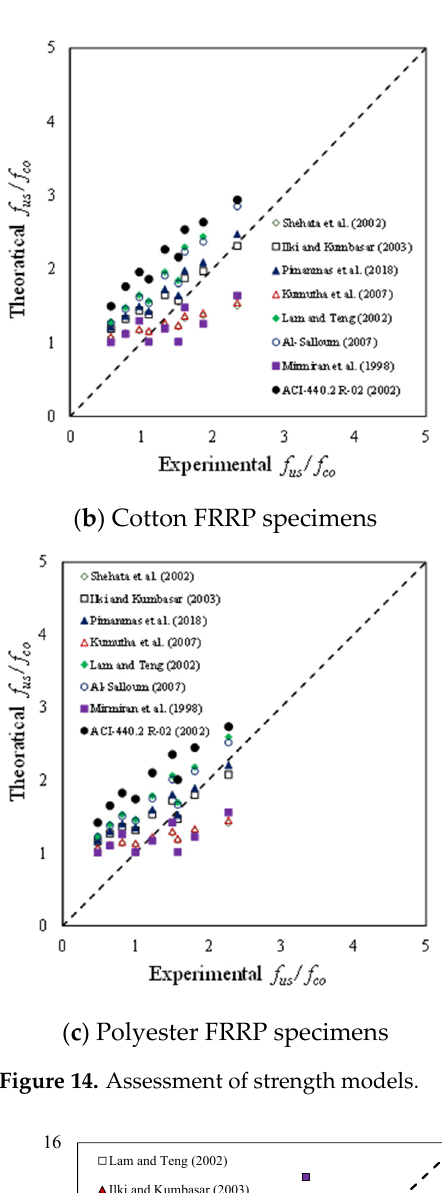
Figure 14. Assessment of strength models.